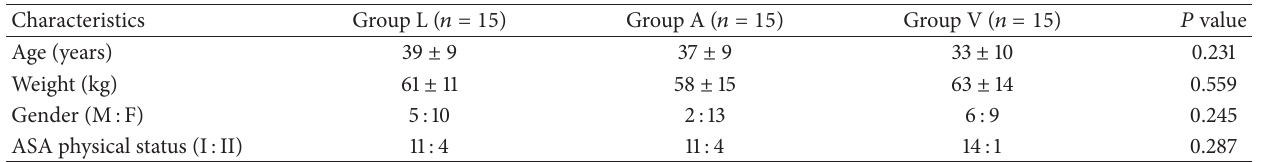
Table 1: Patient characteristics.